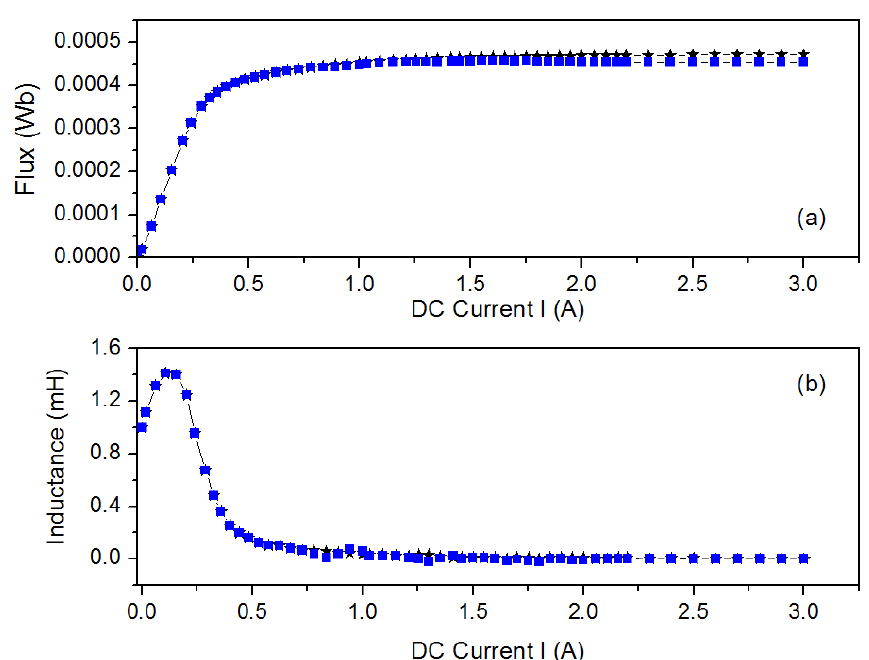
Figure 11. Results for the E34/14/9 ferrite core. ( a ) Φ - I curves; and ( b ) L - I curves. Experiment (– * –) and 2D simulations (–  –) with g = 5 µm.